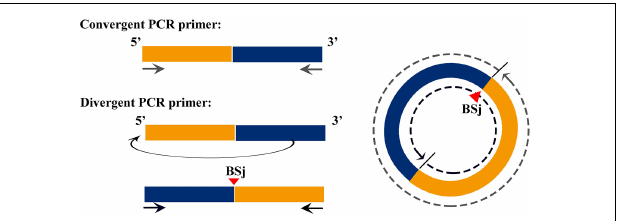
FIGURE 1 | Schematic of the design of divergent and convergent primers, demonstration of the principle of forward and reverse primer